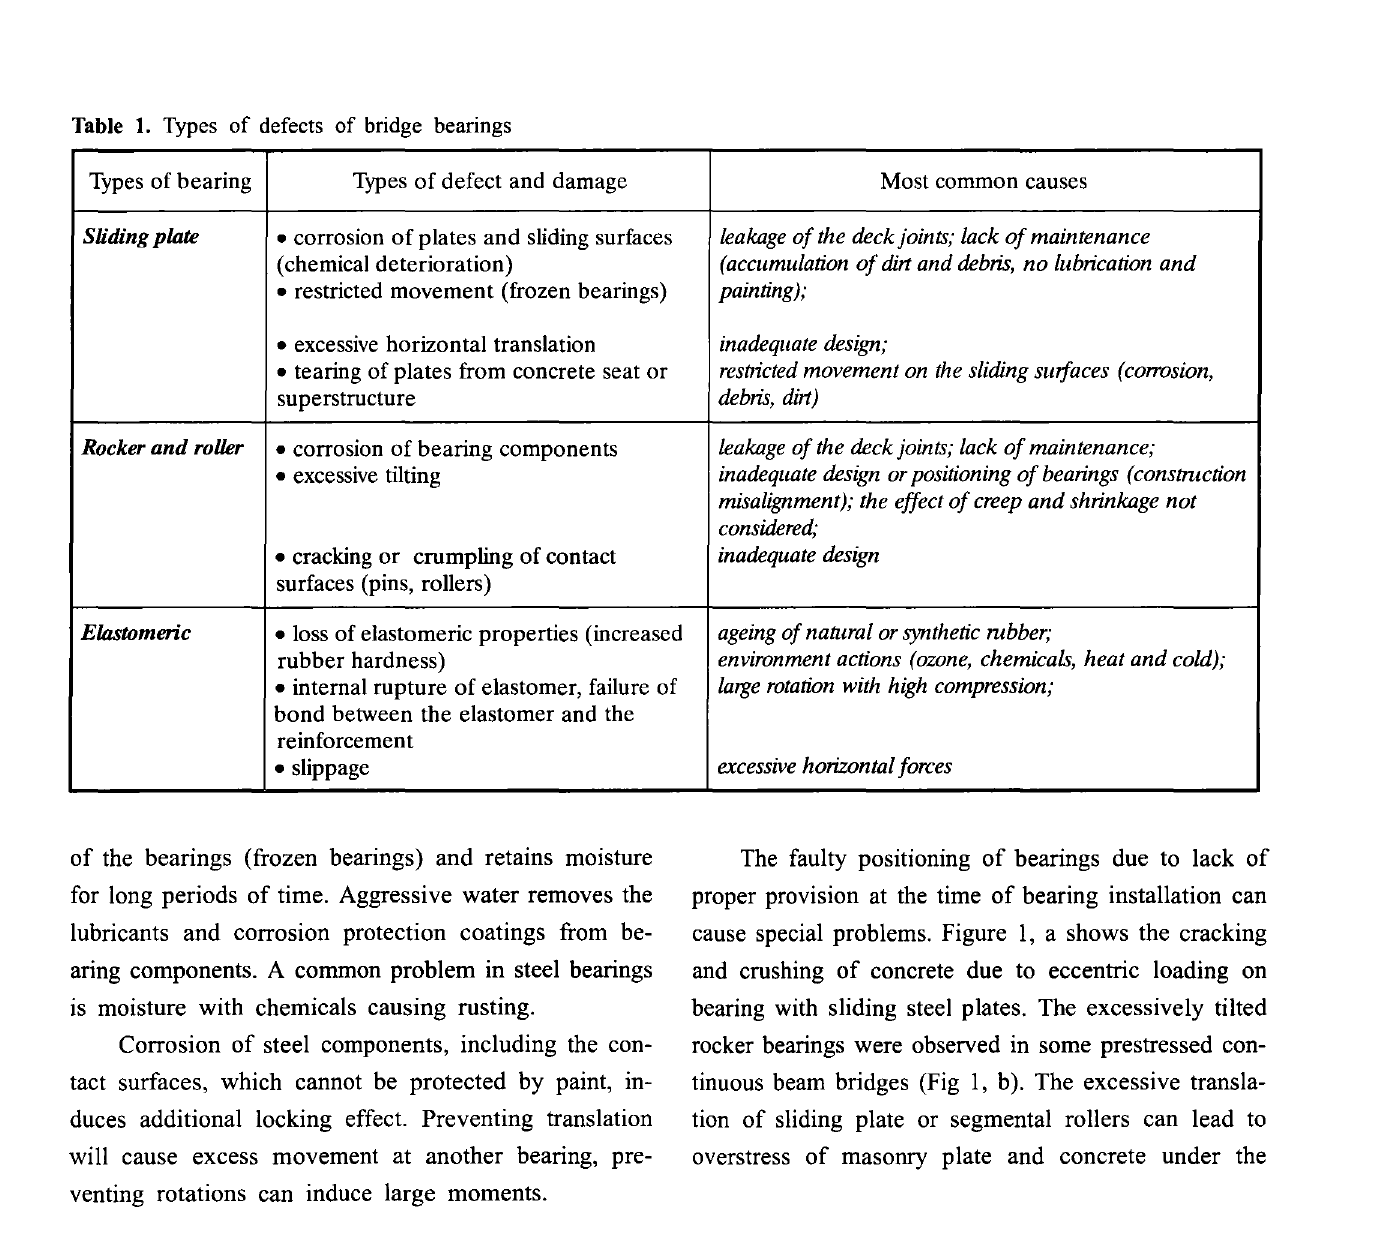
Table 1. Types of defects of bridge bearings Types of bearing